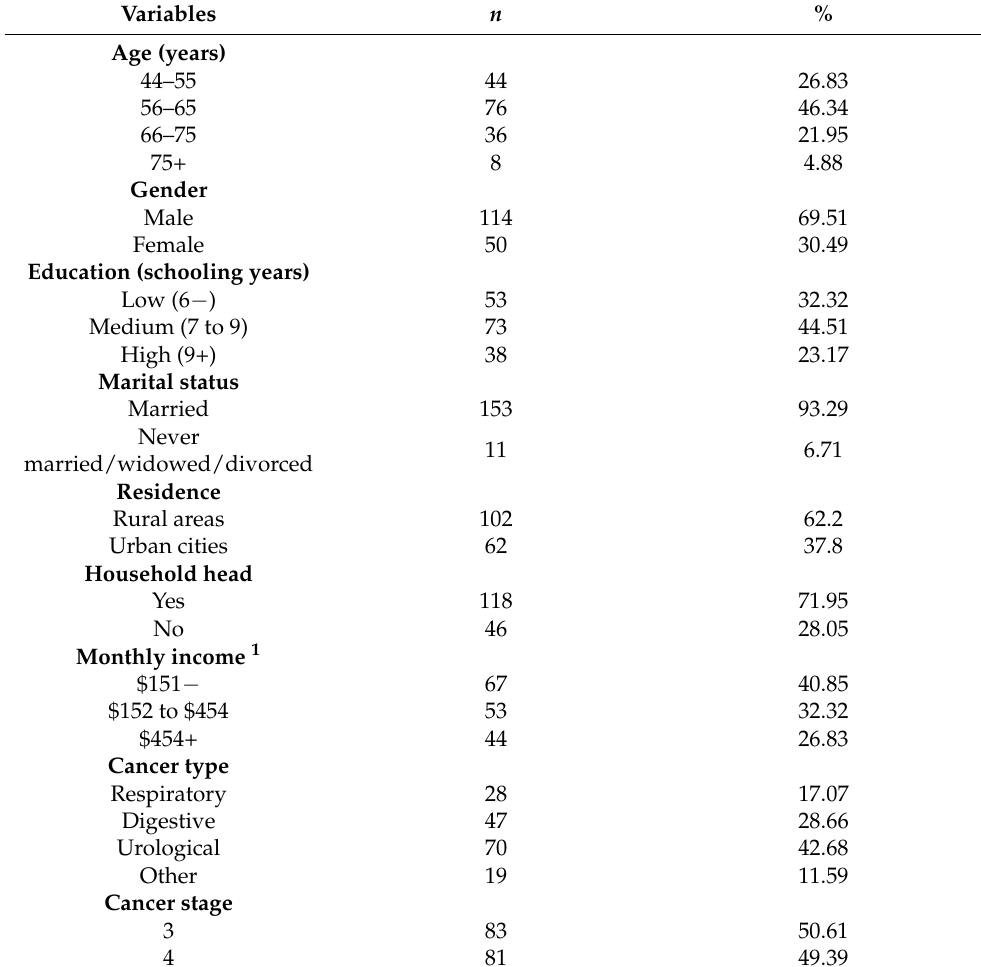
Table 1. Patient baseline characteristics ( n =